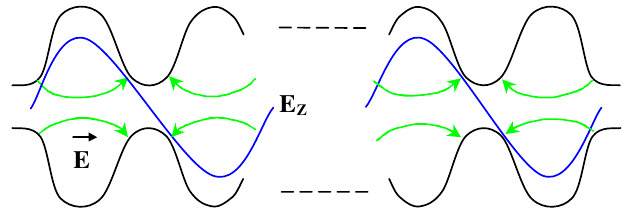
FIG. 1. (Color) Scheme of an n -cell (cid:1) -mode linac. The green lines represent the field lines while the blue line represents the field strength on the